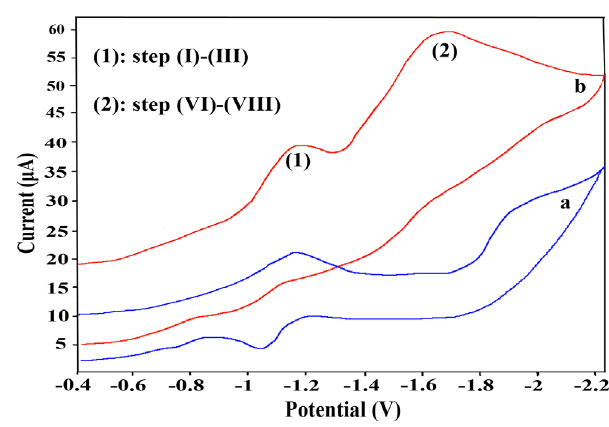
Fig. 8. Cyclic voltammograms of [Gd(L) absence and (b) presence of CO acetonitrile; 0.1 M TBAH.